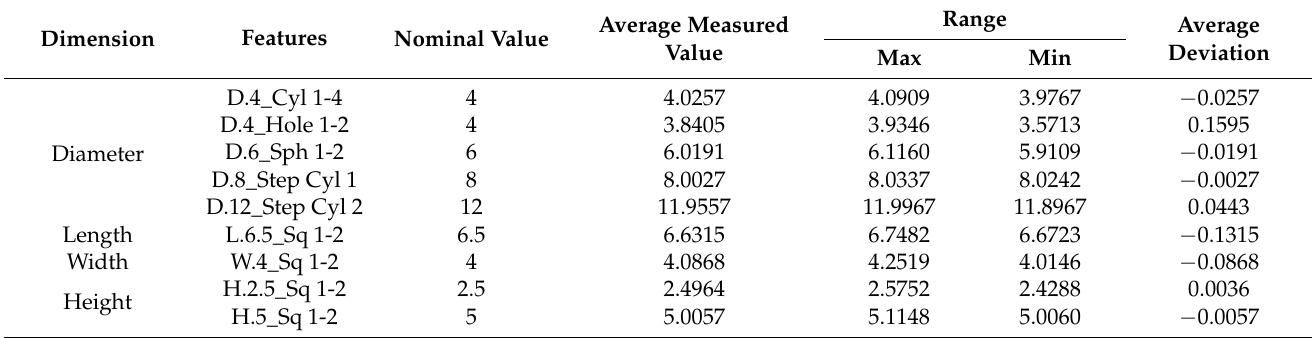
Table 16. Casting measurement results for dimensional accuracy, in mm.